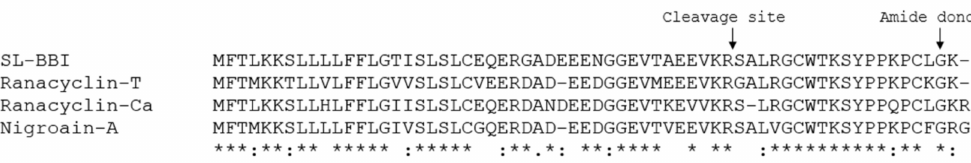
Figure 2. Alignments of partial translated amino acids sequences of Ranacyclin peptides. Ranacyclin T, Ranacyclin Ca and Nigroain-A were identified from Rana temporaria , Lithobates catesbeianus and Sylvirana nigrovittata , respectively [2,30]. Amino acid sequences aligned in ClustalW format were analysed by Clustal W2 multiple sequence alignment program. Asterisk, colons and periods indicate the conservation of residues from high to